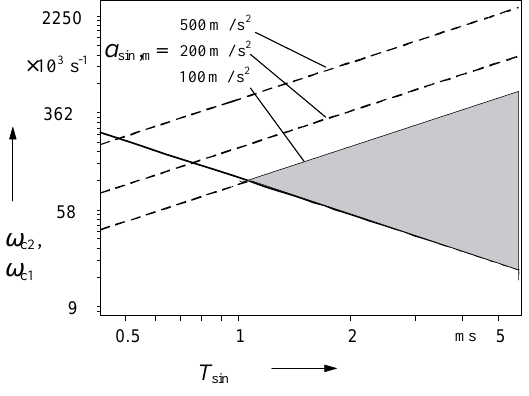
Fig. 5. Lower (solid) and upper (dashed) limits of the low-pass filter cut-off frequency (Eq. 27) as a function of the impulse duration T sin